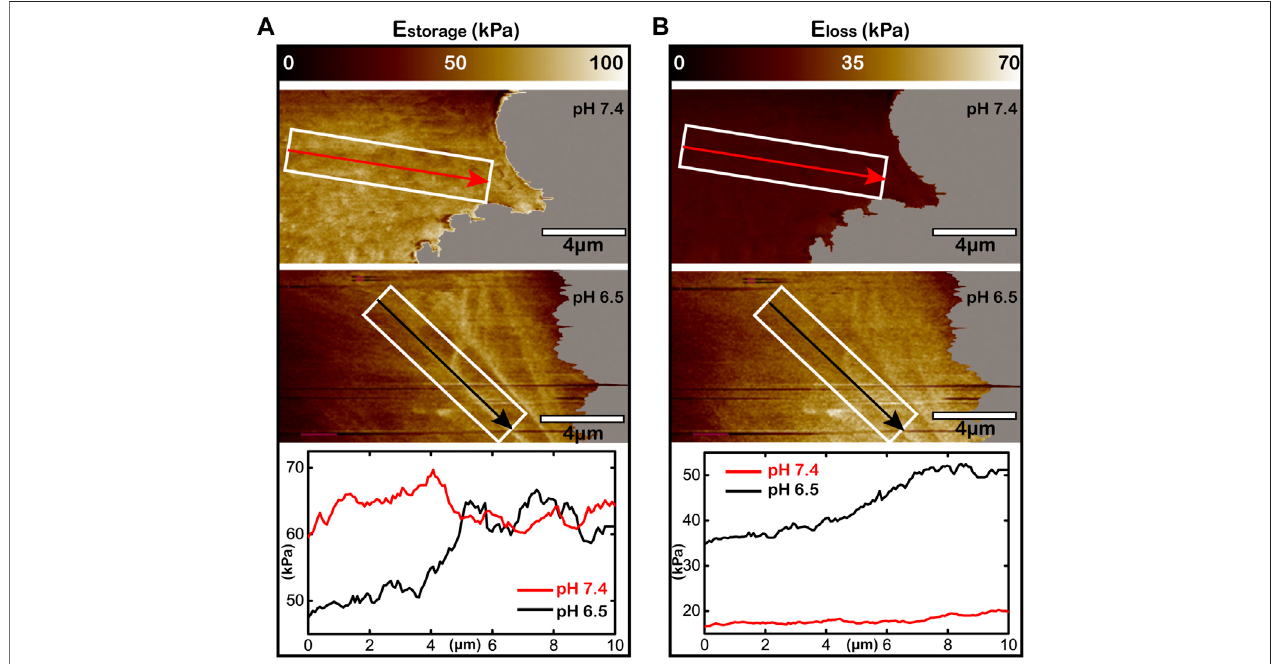
FIGURE 7 | Acid microenvironment inducing viscoelasticity gradient in the lamellipodium of living Huh-7 cells. (A , B) The storage modulus for elasticity (A) and the lossmodulusforviscosity (B) ofthelamellipodiumunderdifferentpHenvironments.TheupperpanelsareatpH7.4,themiddlepanelsareatpH6.5,andthelowercurves analyze the storage modulus or the loss modulus within the white rectangular boxes alongthe arrows directed to lamellipodium protrusion. The white rectangular boxes with the directions of arrows are the same for each pH value.